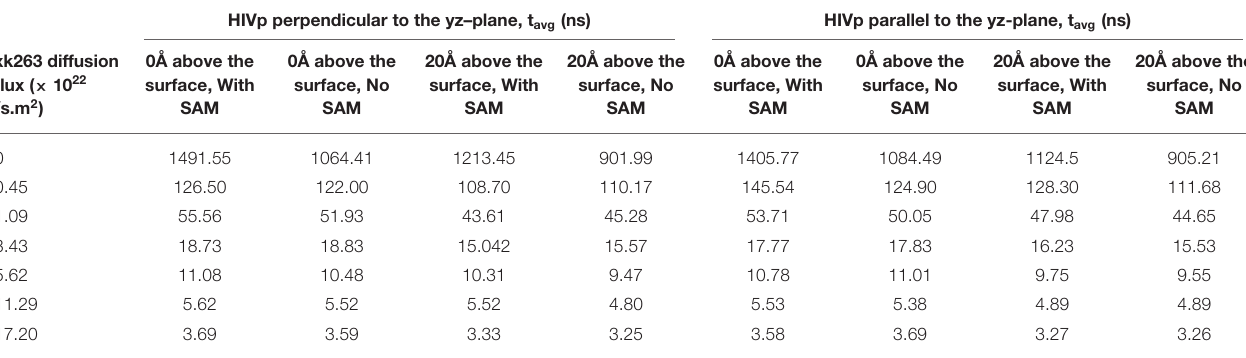
TABLE 3 | Average association time (t avg ) with different xk263 diffusion fluxes.